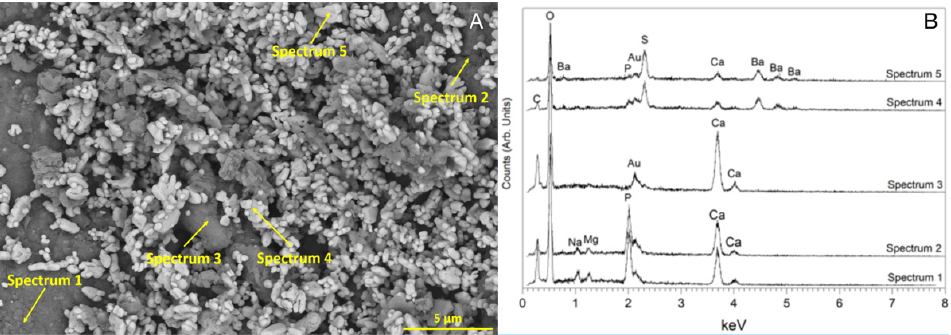
Figure 3. ( A ) SEM image showing the globular aspect of CH residues; arrows indicate the areas analyzed with EDX, ( B ) EDX spectra relative to areas indicated in ( A ). analyzed with EDX, ( B ) EDX spectra relative to areas indicated in ( A ).